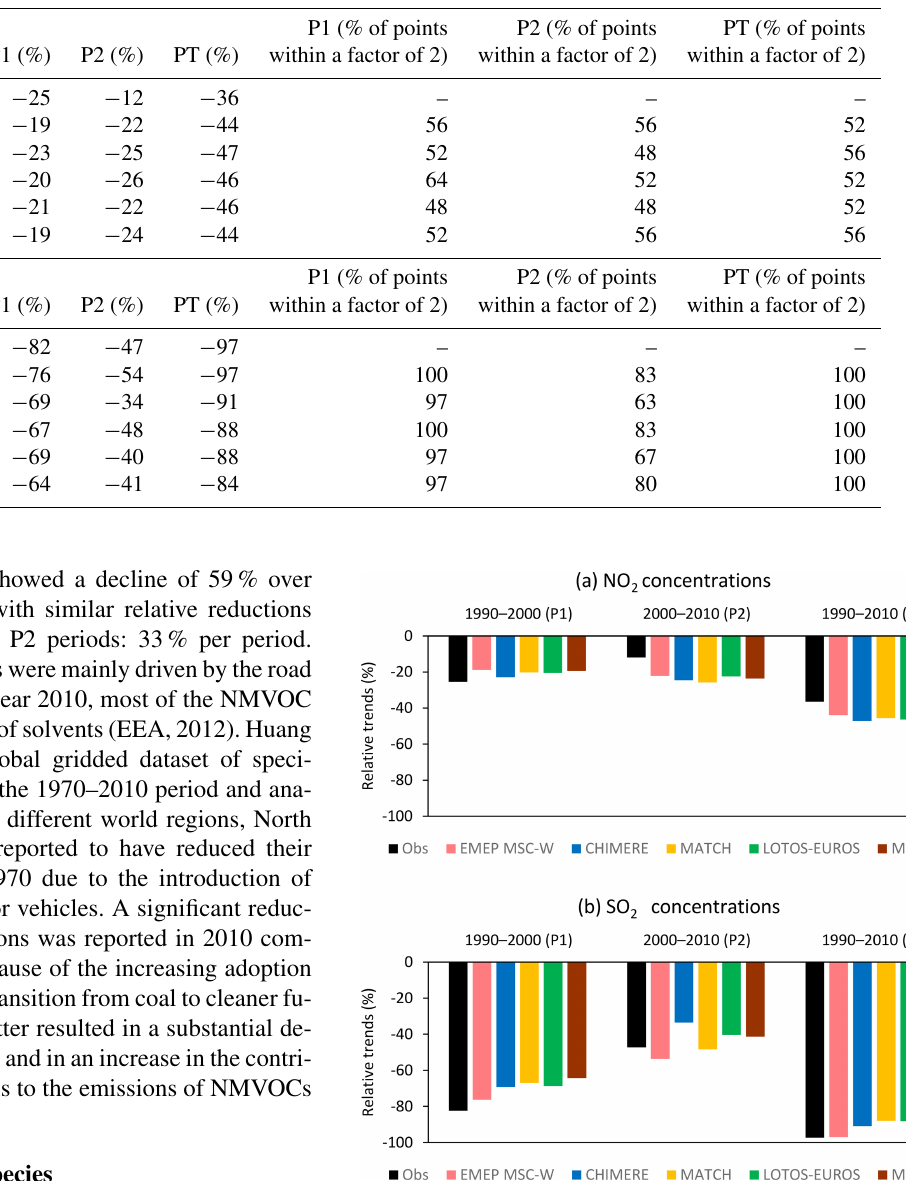
Table 3. Modeled and observed mean relative trends of NO 2 and SO 2 for the P1 (1990–2000), P2 (2000–2010) and PT (1990–2010) periods and percentage of points in Fig. 3 within a factor of 2 of the observed trends.